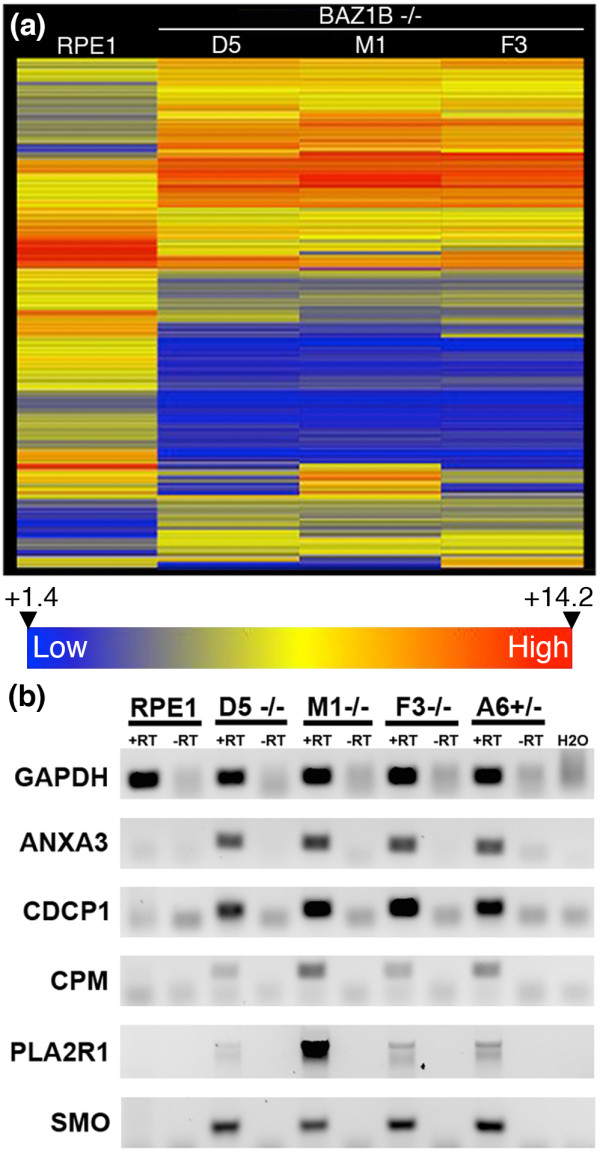
Gene expression changes in BAZ1B -/- cells. (a) Dendrogram (Heat Map) of hierarchical clustering of gene expression between RPE1 and three independent BAZ1B -/- clones. Heat map represents 586 data points, corresponding to probes showing greater than 2-fold change in gene expression at 95% confidence. Expression levels range from +1.4 to +14.2, corresponding to signal intensity on the microarray and represented by a blue (low) to red (high) gradation indicated by the scale bar beneath the heat map. Each column represents the averaged signal from three replicate data sets for each clone. Each row represents a single specific probe. Changes in gene expression can be seen by the difference in row colors between the mutants and parental cells. (b) Representative examples of genes activated in BAZ1B -/- cells by standard end-point RT-PCR analysis shown as an inverted image of an ethidium bromide stained agarose gel. The gene name is given to the left, and the cell line indicated at the top. Lanes show with (+RT) and without (-RT) reverse transcriptase and a water control (H2O).